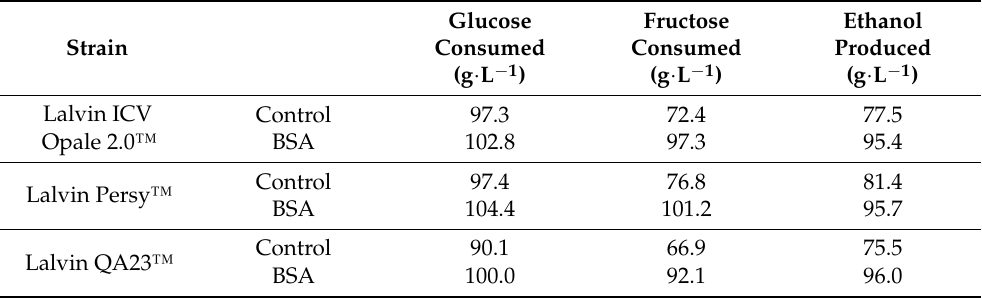
Table A1. Glucose, fructose and ethanol measurements at the start and end of fermentation with is without added peptides. ‘BSA’ is with added peptides.